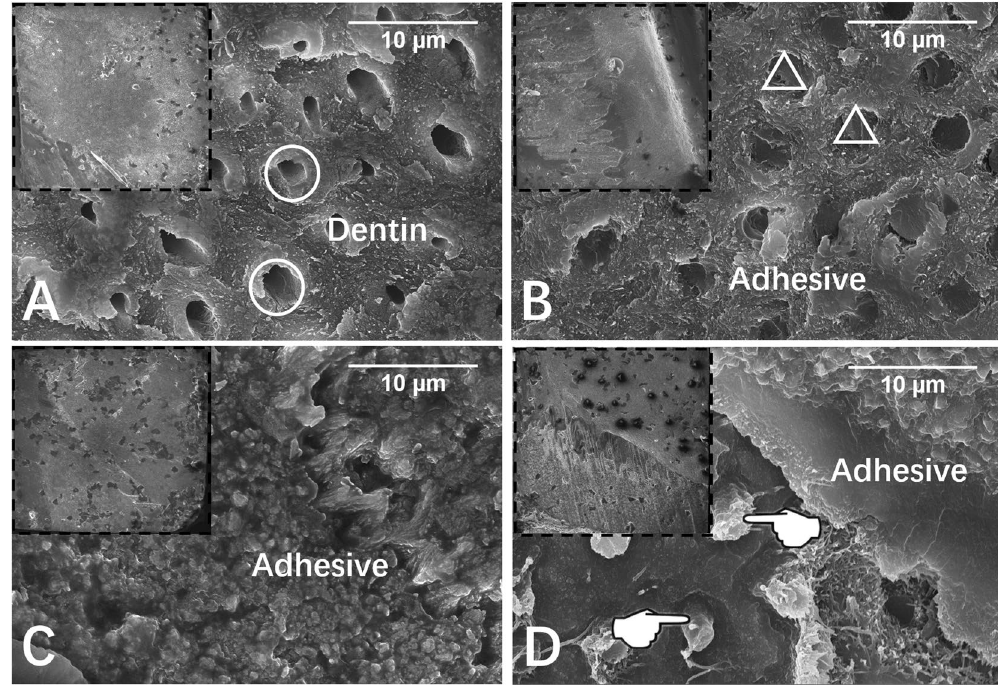
Figure 5. Representative FESEM images (3000 × ) of fractured dentin sides after microtensile bond strength test. The insert indicates general condition of fractured surfaces (80 × ). ( A ) Cohesive failure in dentine, from collagenase-aged control group; ( B ) cohesive failure in composite, from collagenase-aged quercetin-doped (1000 ug/mL) group; ( C ) adhesive failure, from immediate quercetin-doped (100 ug/mL) group; ( D ) mixed failure, from immediate quercetin-doped (500 ug/mL) group. Circle: open dentin tubules; triangle: sealed dentin tubules; pointer: resin